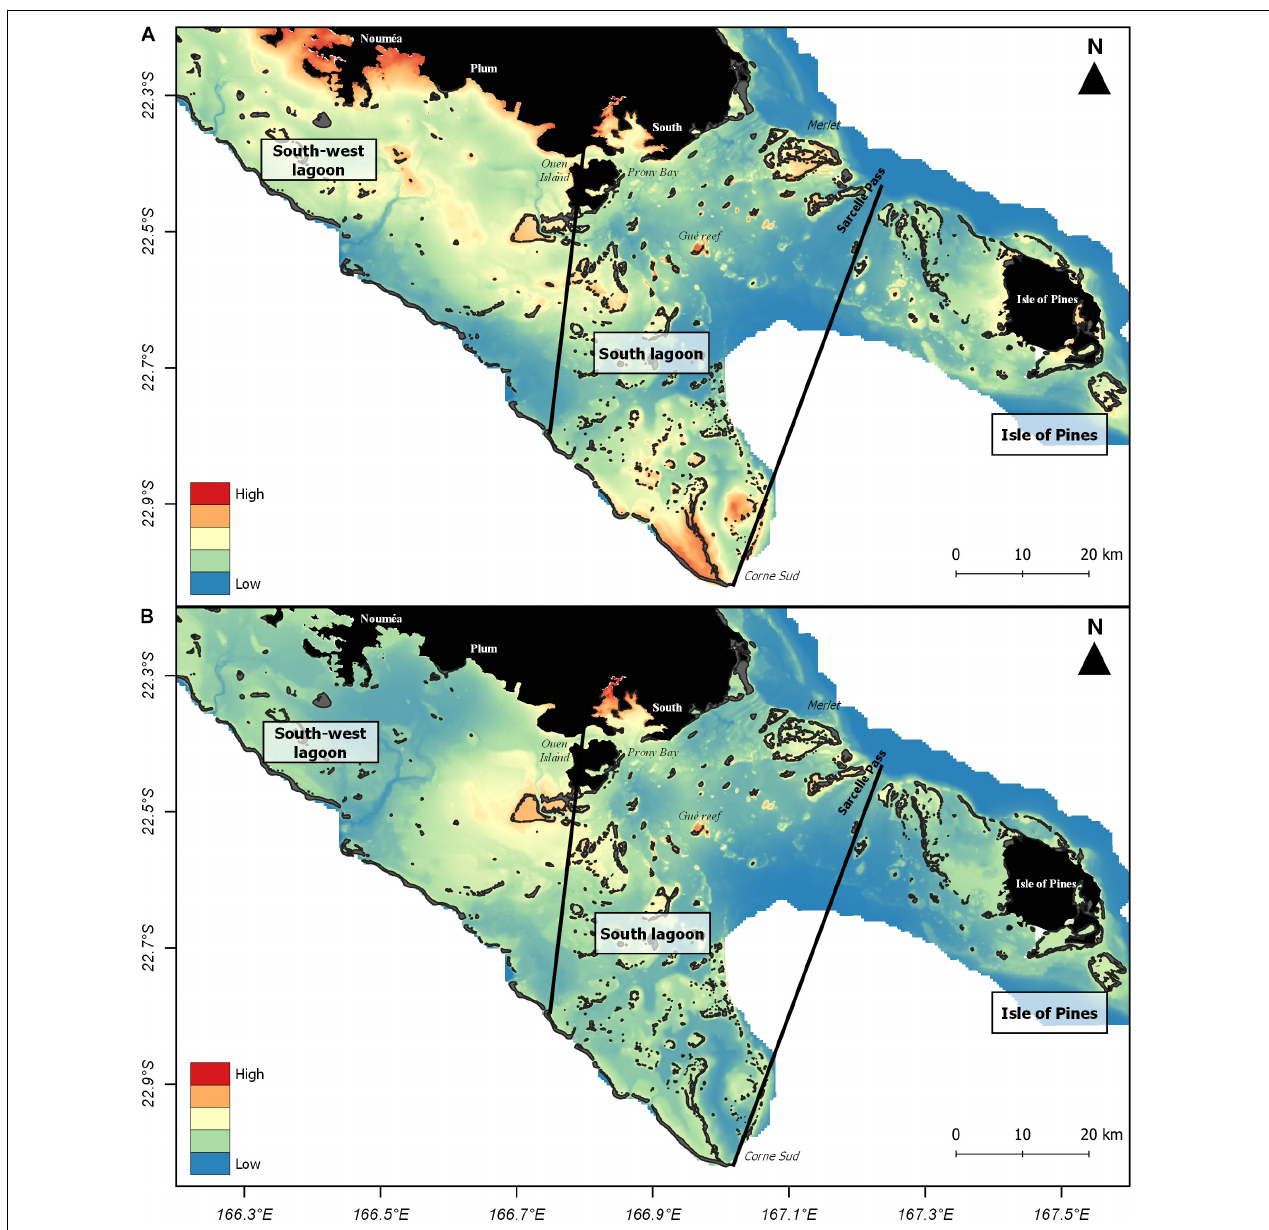
FIGURE 3 | Predicted winter habitat suitability for Indo-Pacific bottlenose dolphins in the southern range of New Caledonia. (A) Environmental model M env ; (B) Combined environmental-spatial model M env-spa . Approximate boundaries to the south-west lagoon, the south lagoon and the Isle of Pines are represented with black lines. Predicted habitat suitability is represented on a colored scale from high suitability (red) to low suitability (blue). Land and shallow reefs are shown in